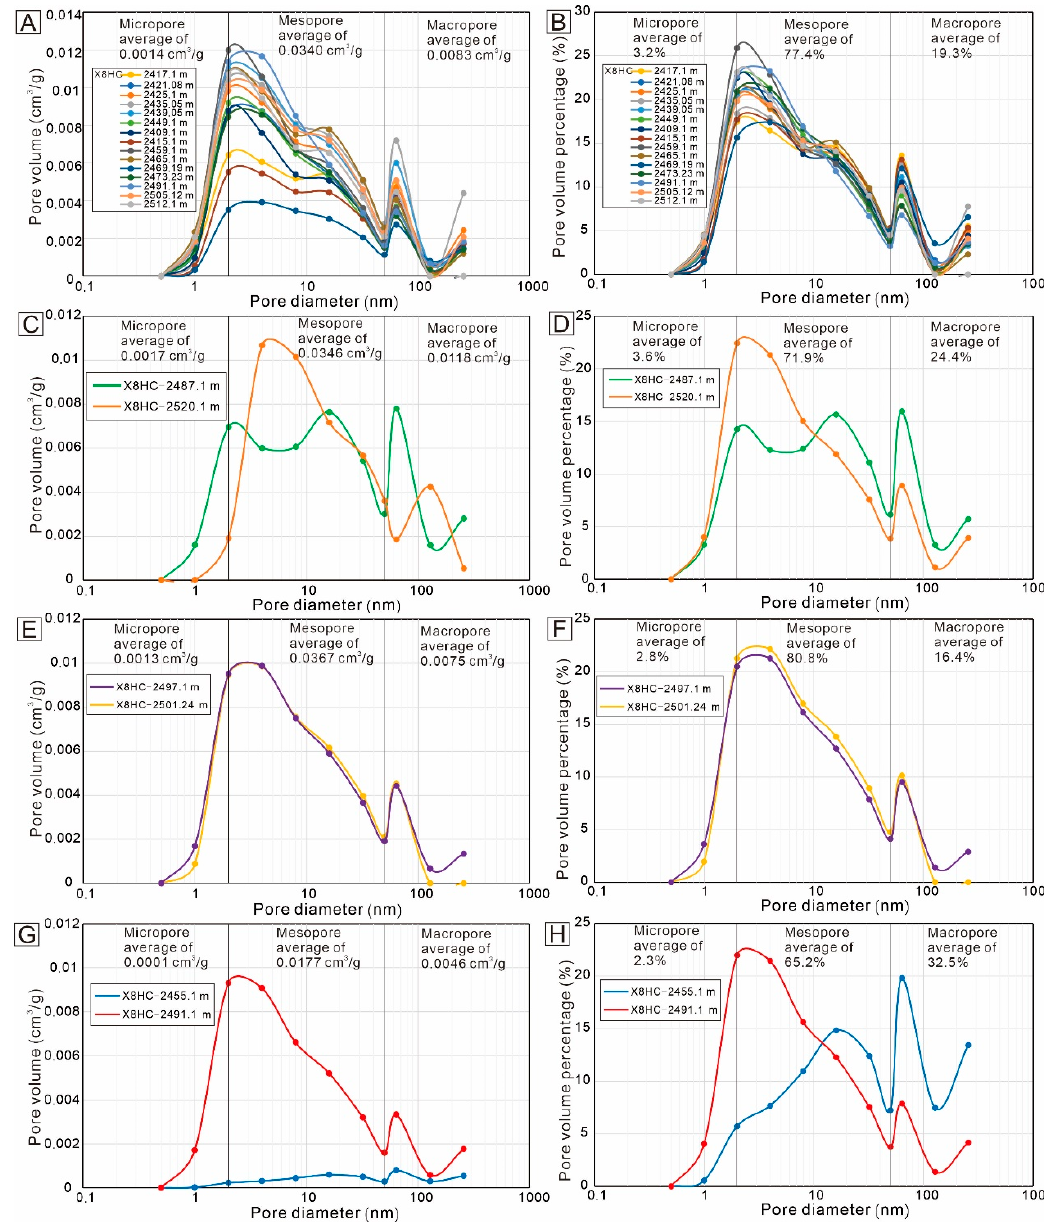
Figure 15. Pore diameter distribution of different lithofacies of FGSRs. ( A , B ) SM lithofacies shales, ( C , D ) SFMR lithofacies shales, ( E , F ) AFMR lithofacies shales, and ( G , H ) CM lithofacies Table 2. SSA and average adsorption pore diameter of different lithofacies of FGSRs in the Qingshankou Formation.